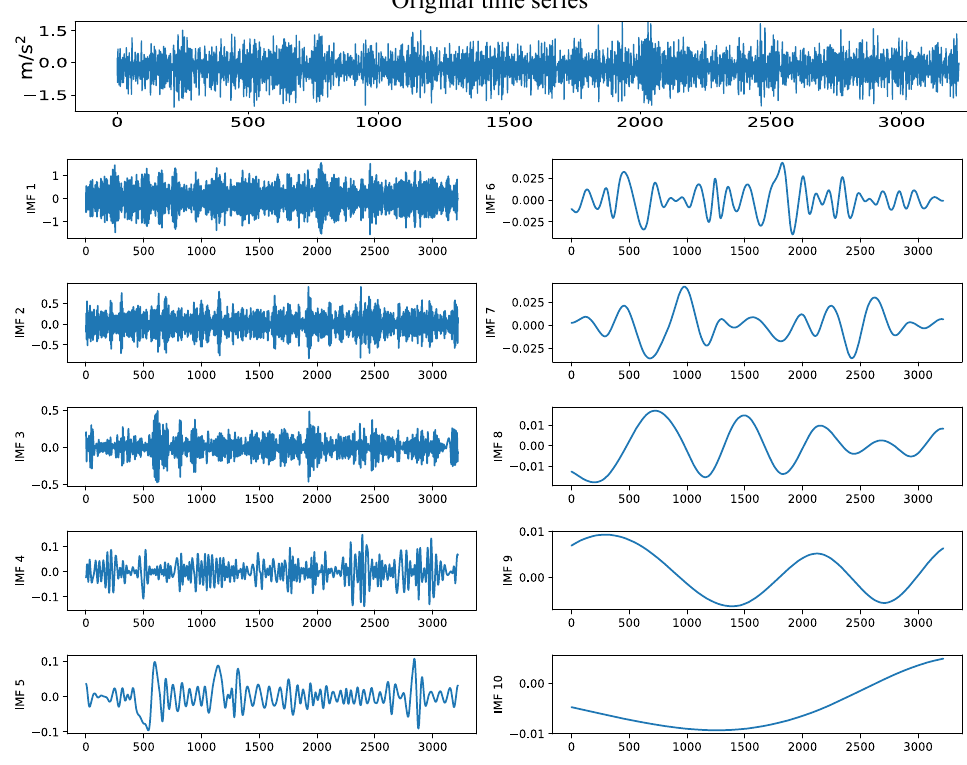
Figure 1. EMD decomposition of acceleration data for a three-story building structure.